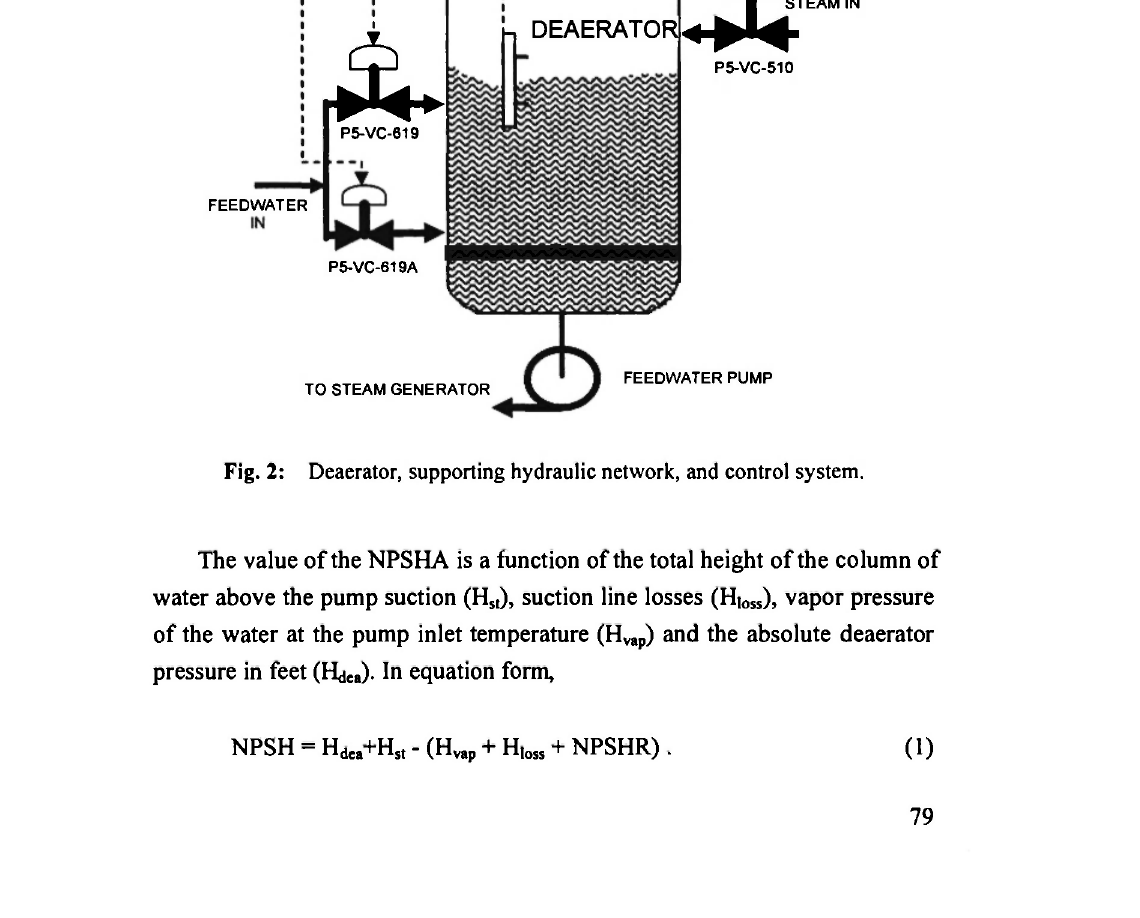
NPSH = H dea +H st - (H vap + Hioss +